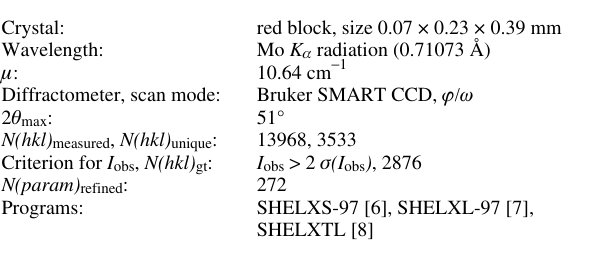
Table 1. Data collection and